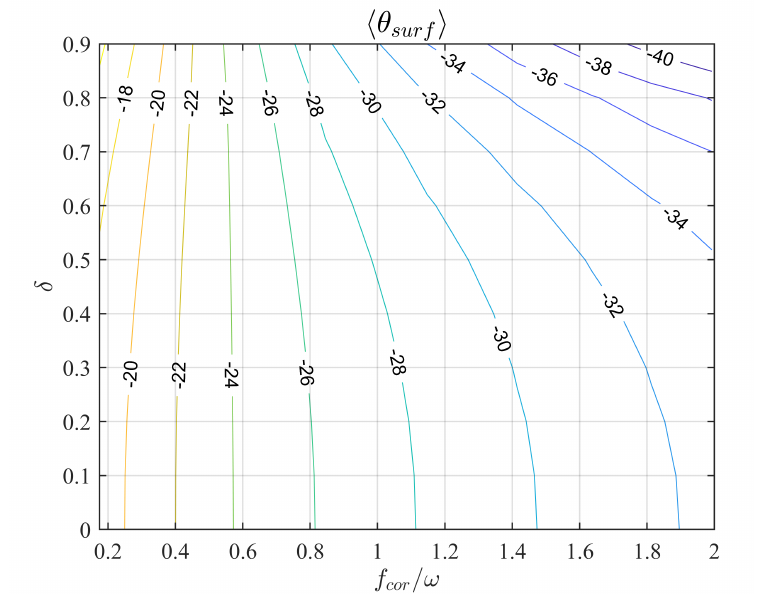
Figure 9. Direction of the time-averaged surface currents under positive zonal wind stress; negative values indicate clockwise